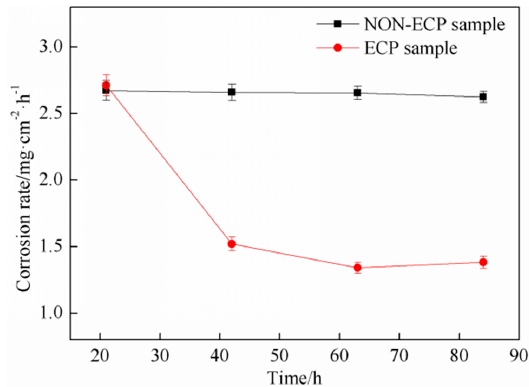
Figure 8. Relationship between corrosion rate and corroding time.